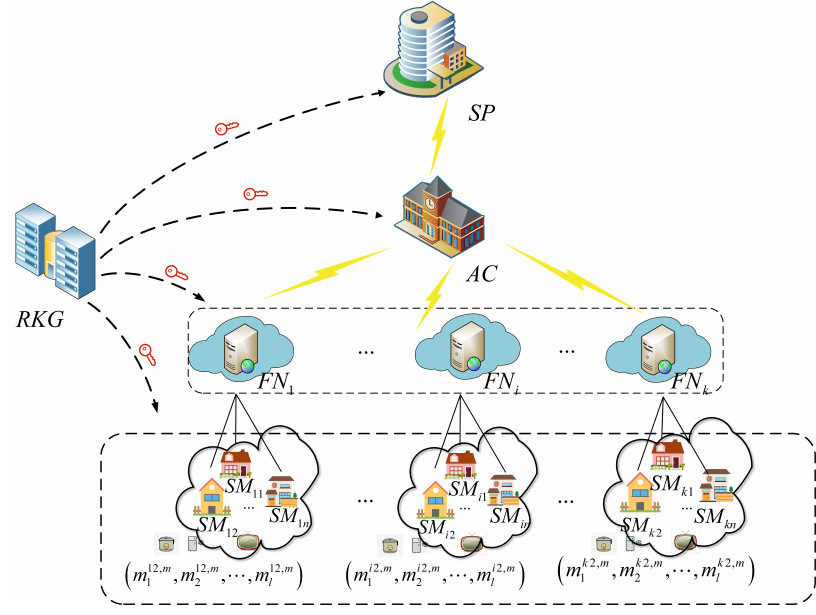
Figure 2. System